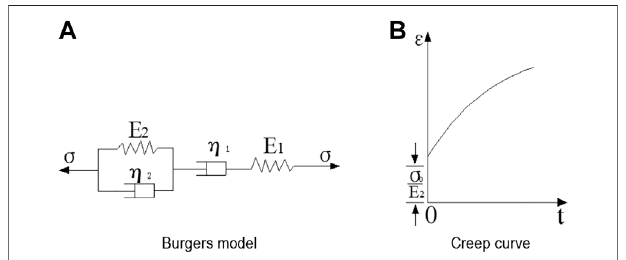
FIGURE 4 | Burgers model. (A) Burgers model. (B) Creep